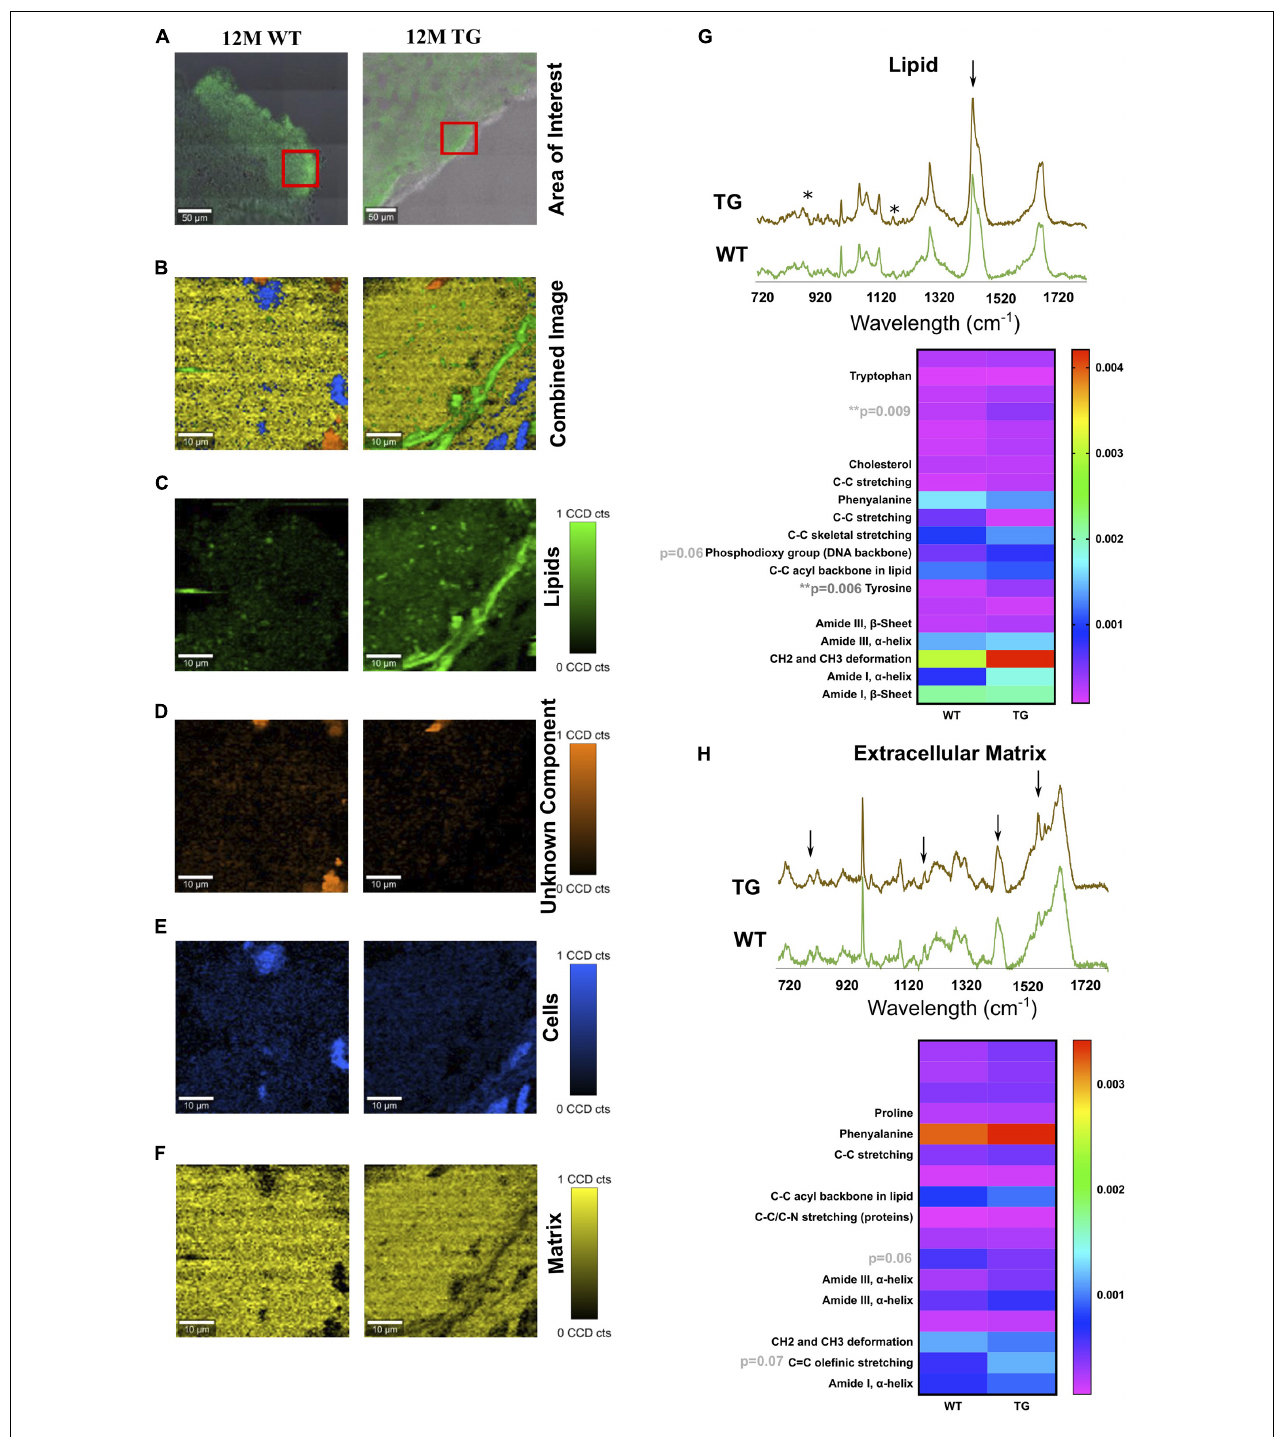
FIGURE 2 | TCA of selected areas in the olfactory bulb of WT and TG animals. (A) The measured area is shown in red boxes. (B) The combined image of all the components is shown. (C) The separated components through TCA were lipids in green, (D) an unknown component in orange, (E) cells in blue, and (F) extracellular matrix components in yellow. The CCD count interval was listed for all the components. (G , H) The components displaying the same results were put together and averaged in their groups. The two components (lipids and extracellular matrix) out of five appeared to be different in most samples. x -axis represents the wavelength in centimeters while y -axis shows the spectral intensity. The separated groups were 12M WT (green) and 12M TG (brown). Differences in the lipid component were observed for intensity at unassigned peak 873 cm − 1 ( p = 0.009) and tyrosine ( p = 0.006) between 12M WT and TG based on Student’s unpaired t -test. Heatmap represents the extracellular matrix component, some apparent difference in the spectra for unassigned molecule and C = C olefinic stretching; however, it did not reach a significant level. p -Value represents * p ≤ 0.05 and ** p ≤ 0.01.